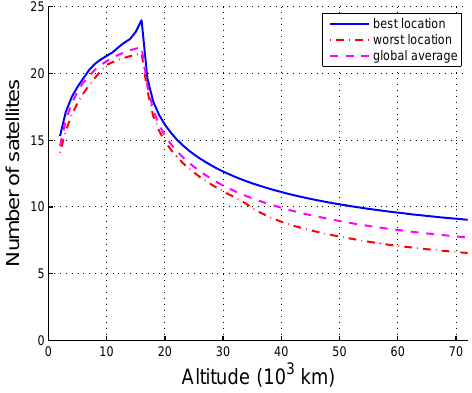
Figure 4. Availability as a function of